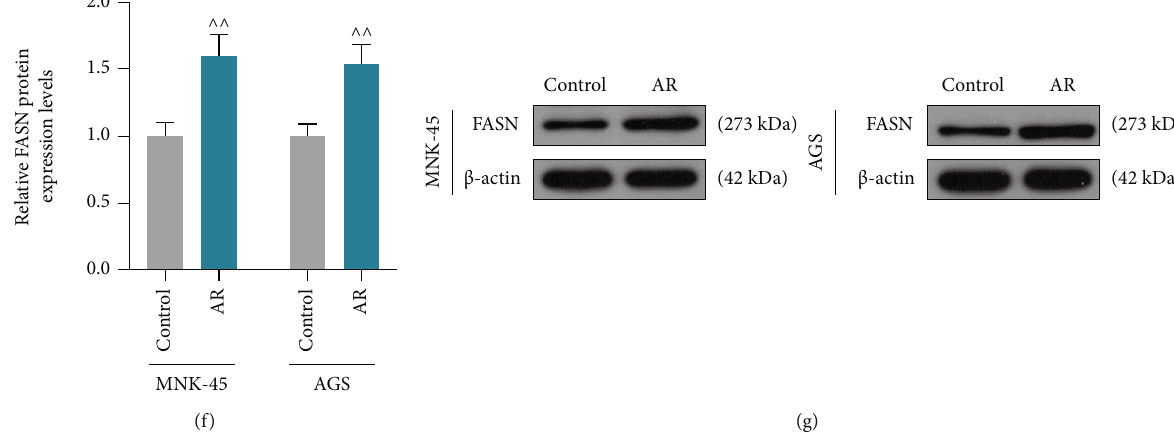
Figure 2: Anoikis resistance (AR) promoted gastric cancer cell migration and invasion, and fatty acid synthase (FASN) was related to AR. (a) Representative images of the migration of MNK-45 and AGS cell in the AR and control groups determined by wound healing assay. (b) Relative migration rates of MNK-45 and AGS cells in the AR and control groups were determined by wound healing assay. (c) Representative images of the invasion of MNK-45 and AGS cell in the AR and Control groups determined by Transwell invasion assay. (d) Relative invasion rates of MNK-45 and AGS cells in the AR and control groups were determined by Transwell invasion assay. (e) Relative FASN mRNA expression levels in MNK-45 and AGS cells in the AR and control groups were evaluated by quantitative reverse transcription-polymerase chain reaction (qRT-PCR). (f) Representative pictures of relative FASN protein expression levels in MNK-45 and AGS cells in the AR and control groups during western blot. β -Actin was used as a loading control. (g) Relative FASN protein expression levels in MNK-45 and AGS cells in the AR and control groups were assessed by western blot. Cells under adherent culture were used as the control group and received no treatment. ^^ p < 0.01 vs. control group; ^^^ p < 0.001 vs. control group. Data were performed as the means ±